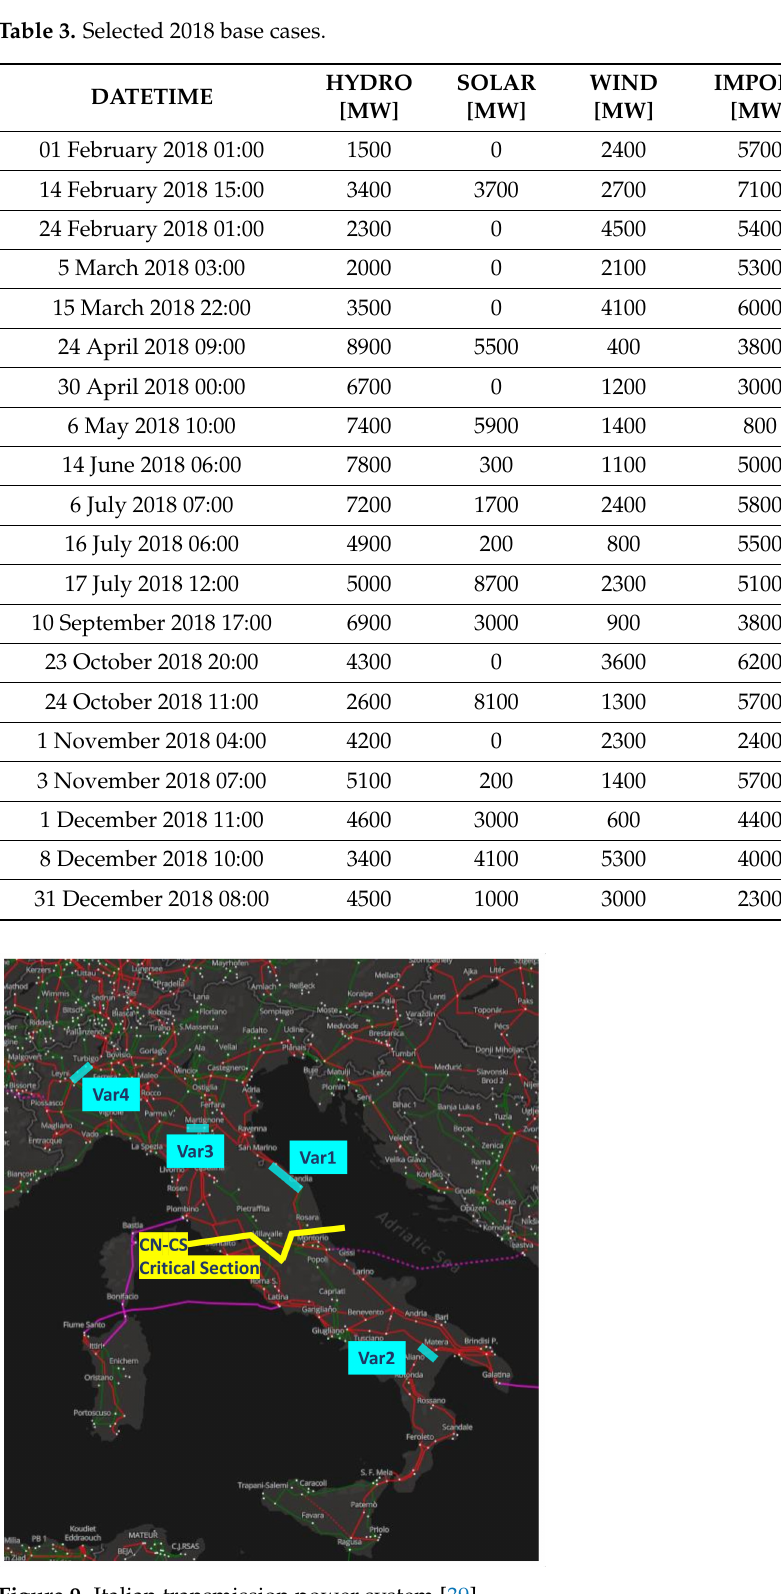
Figure 9. Italian transmission power system [39]. Additionally, the border between the actual Central North (CN) and Central South (CS) bidding zones (according to the Bidding Zone configuration in place in 2018) has been represented as a relevant critical section according to (19) (see Figure